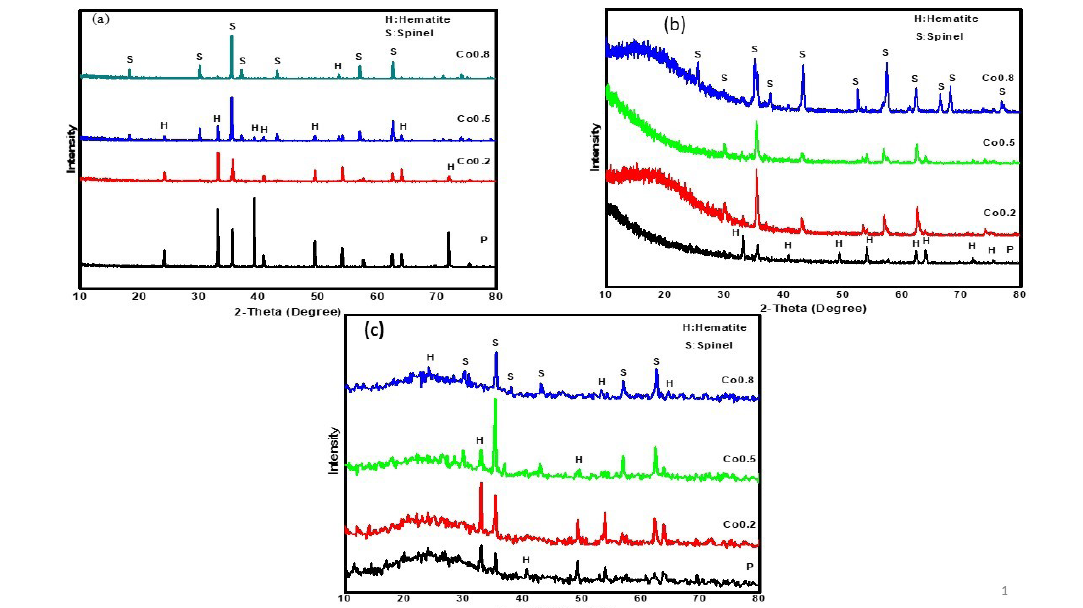
Figure 1. XRD for Cobalt-Zinc ferrites with different Co concentration prepared by microwave method at (a) 800ºC (b) 1000 o C (c) 1400 o